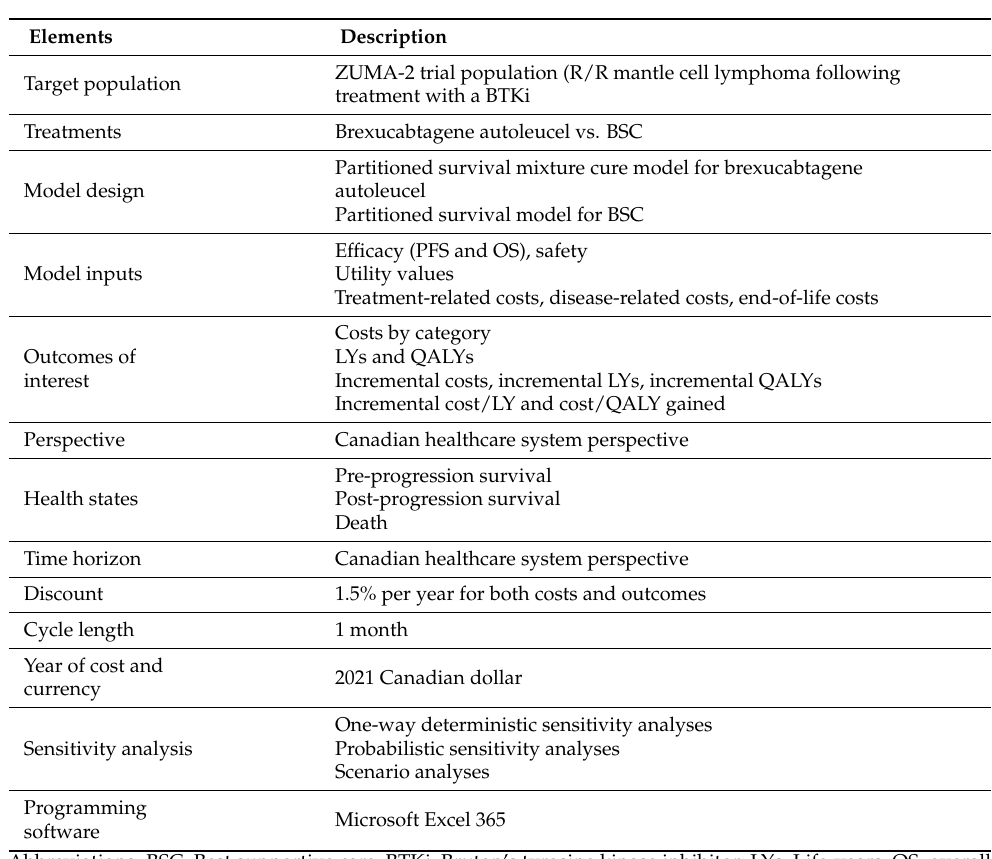
Table 1. Summary of modeling approach .